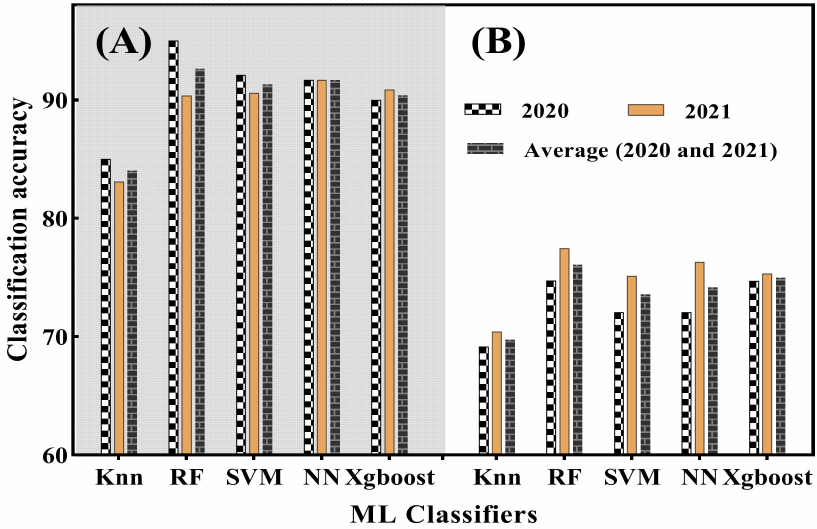
Figure 8. Comparison of classification accuracy (CA) of different machine learning classifiers (MLC): ( A ) CA of different MLC for newly developed canopy indices in 2020 and 2021 and an average of both years. ( B ) CA of different MLC for conventional spectral